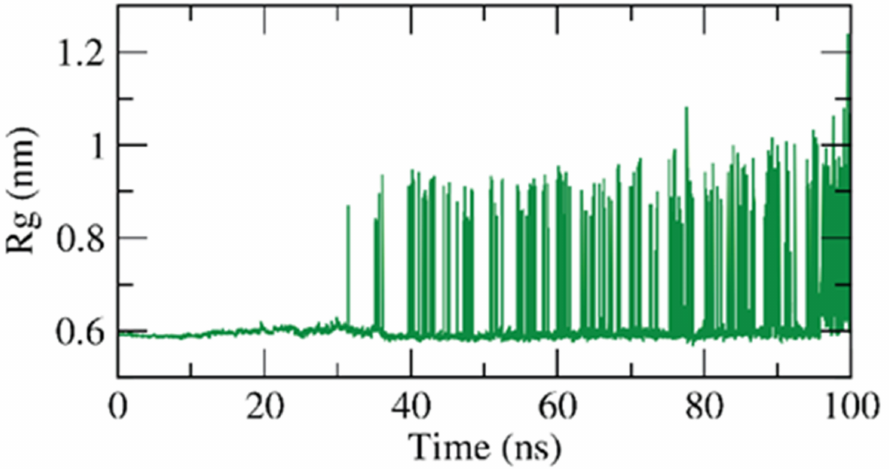
Figure 11. Rg of the β CD-anabasine complex.